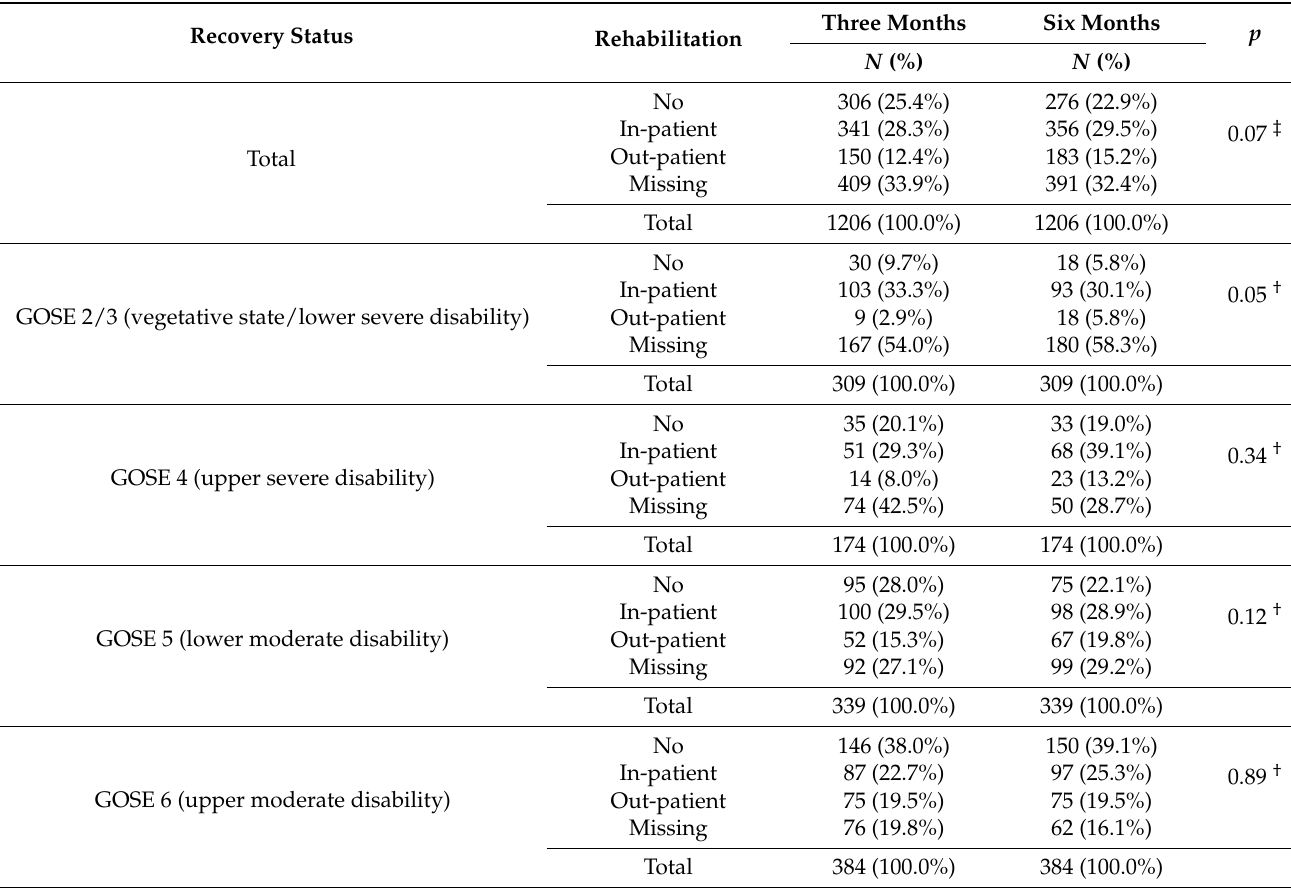
Figure 2. Rehabilitation services provided to individuals with the respective impaired outcomes. Services were ranked based the relative frequency (e.g., physiotherapy was provided more frequently than speech therapy at three months and more frequently than occupational therapy at six months after TBI). Table 4. Rehabilitation services received at there and six months (total and split by recovery status at six